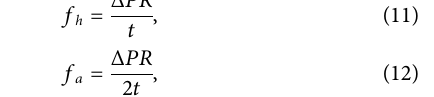
TABLE 4 Computational error for overpressure using three computational models. Distance from the center of Overpressure error calculated Overpressure error calculated by the airship envelope (m) by Brode ’ s equation (%) Brown ’ s equation (%)